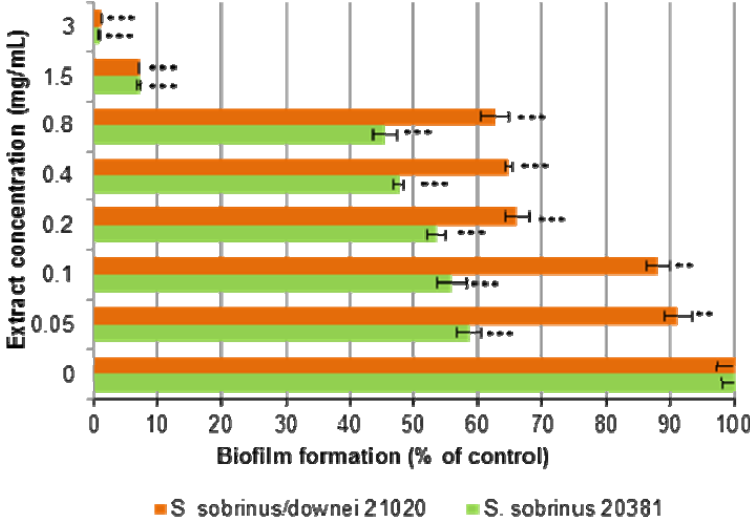
Figure 2. The inhibitory effects of diethyl fraction (PRU2) on mutans streptococci biofilm formation. The relative amount of biofilm formation, at a certain PRU2 concentration, is given compared to non-treated controls. Chlorhexidine, used as a positive control at sub MIC concentration (2.5 mg/L), showed 93.5 ± 0.6 and 95 ± 0.8% inhibition on S. sobrinus/downei 21020 and S. sobrinus 20381 biofilm formation, respectively. Results